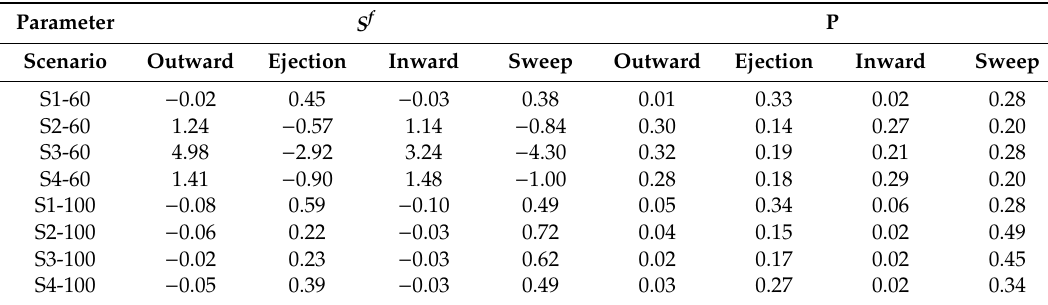
Table 3. Stress fraction and frequency of events for X5Y3 at 60 and 100 L / s flow rates. Parameter S f P